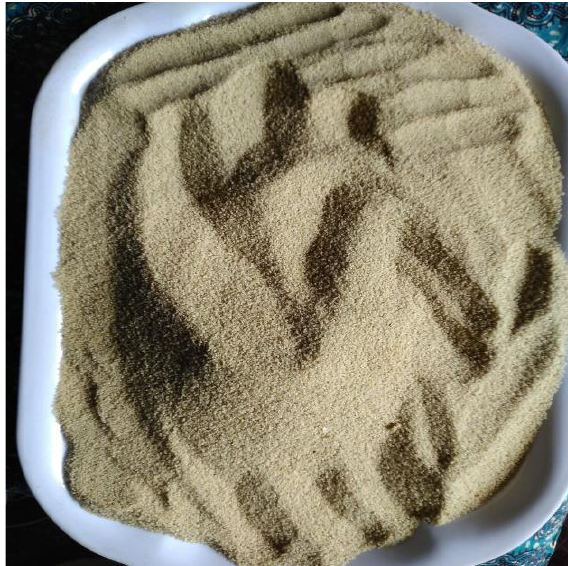
Figure 3. Acha/fonio (Hungary rice).